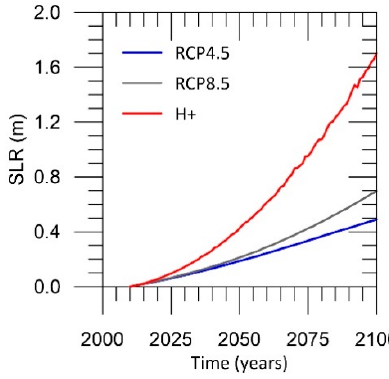
Figure 2. Sea-level rise (SLR) scenarios used in this work.